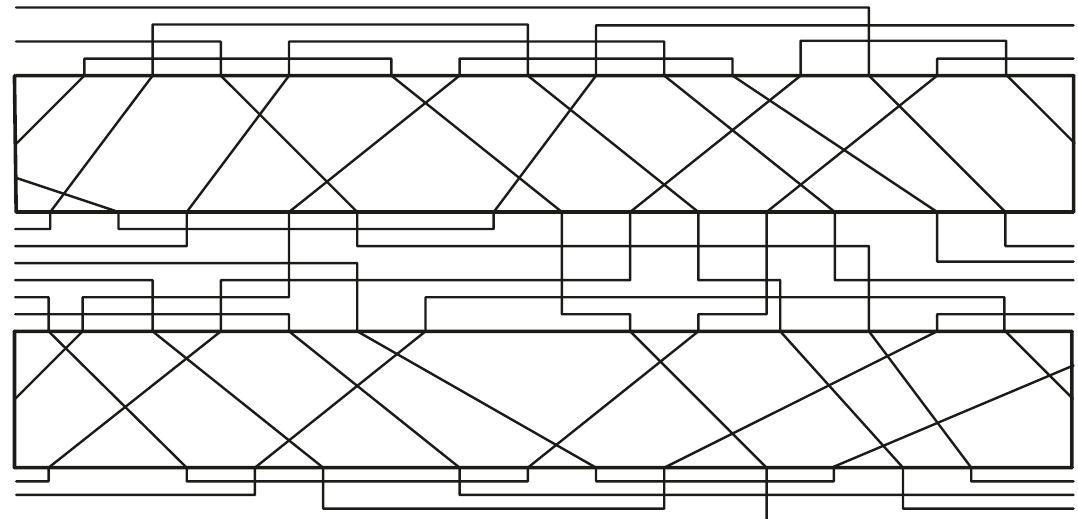
Figure 8: The locomotive operations diagram drawn by the method of this